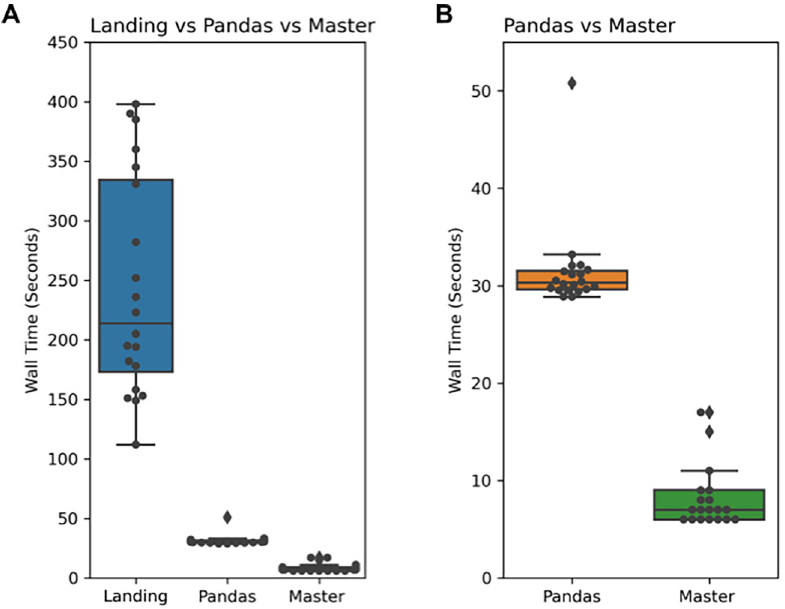
Figure4.Resultsoftheaverageruntime(inseconds)ofexecuting20queriesonthelandingzonevsPandasvs the master zone. A: The wall time comparison between the three different approaches for 20 repeated queries. Afterevaluating theruntimeperformance,queriesrunninginthe masterzoneare~20 – 30timesfaster